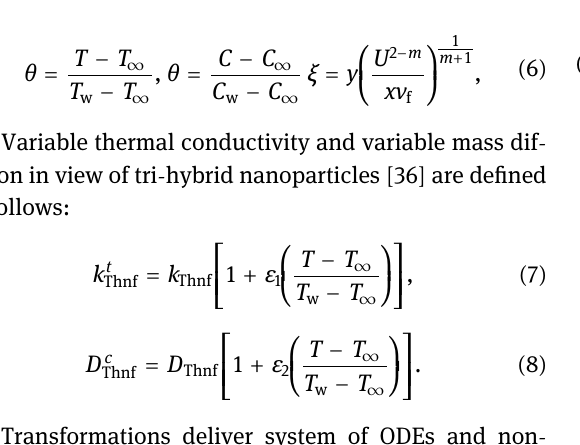
Figure 2: Geometry of the developed